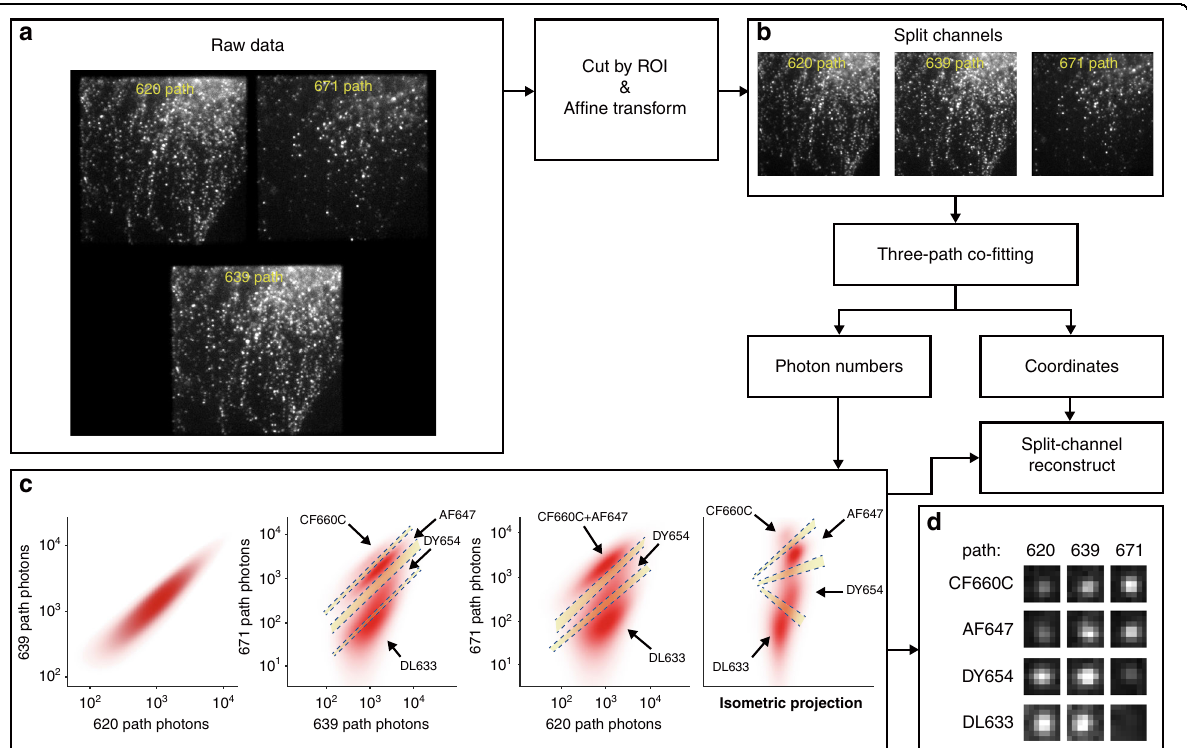
Fig. 2 Work fl ow of ExR-STORM. a One frame of the raw image stack. b Split channels of the raw image based on the ROI of the three light paths, and transformed by the af fi ne matrices to the 639 nm light path. c Diagram of dye assignment along the projections of the 671 path, 620 path, 639 path, and the isometric projection (which is an axonometric projection in which the three coordinate axes appear equally foreshortened and the angle between any two of them is 120 degrees), with the yellow regions between the dashed lines, rejected. d Single-molecule of each dye in the three light paths from ( b ) based on the classi fi cation process shown in ( c